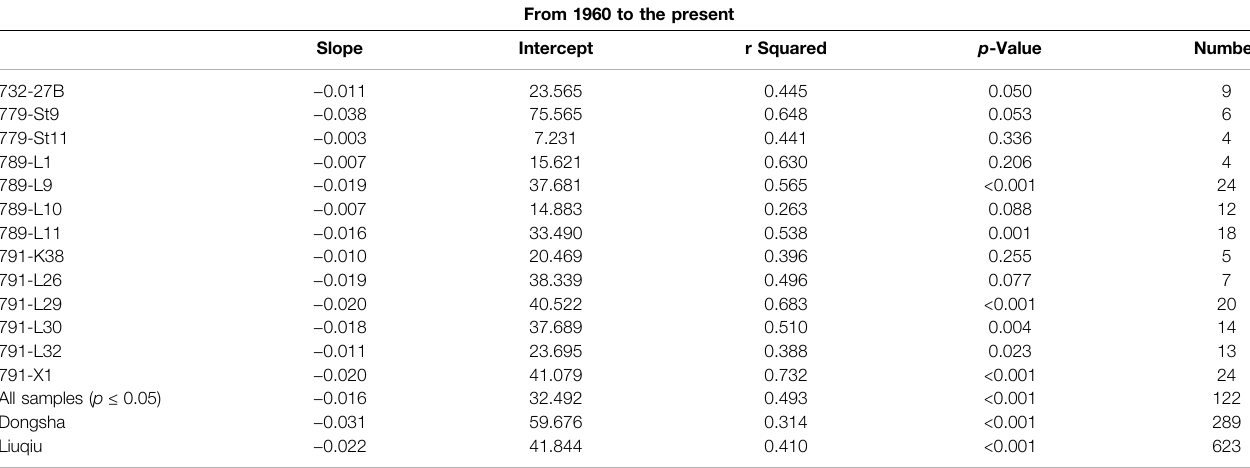
TABLE 3 | Linear regression analyses of δ 13 C from 1960 to the